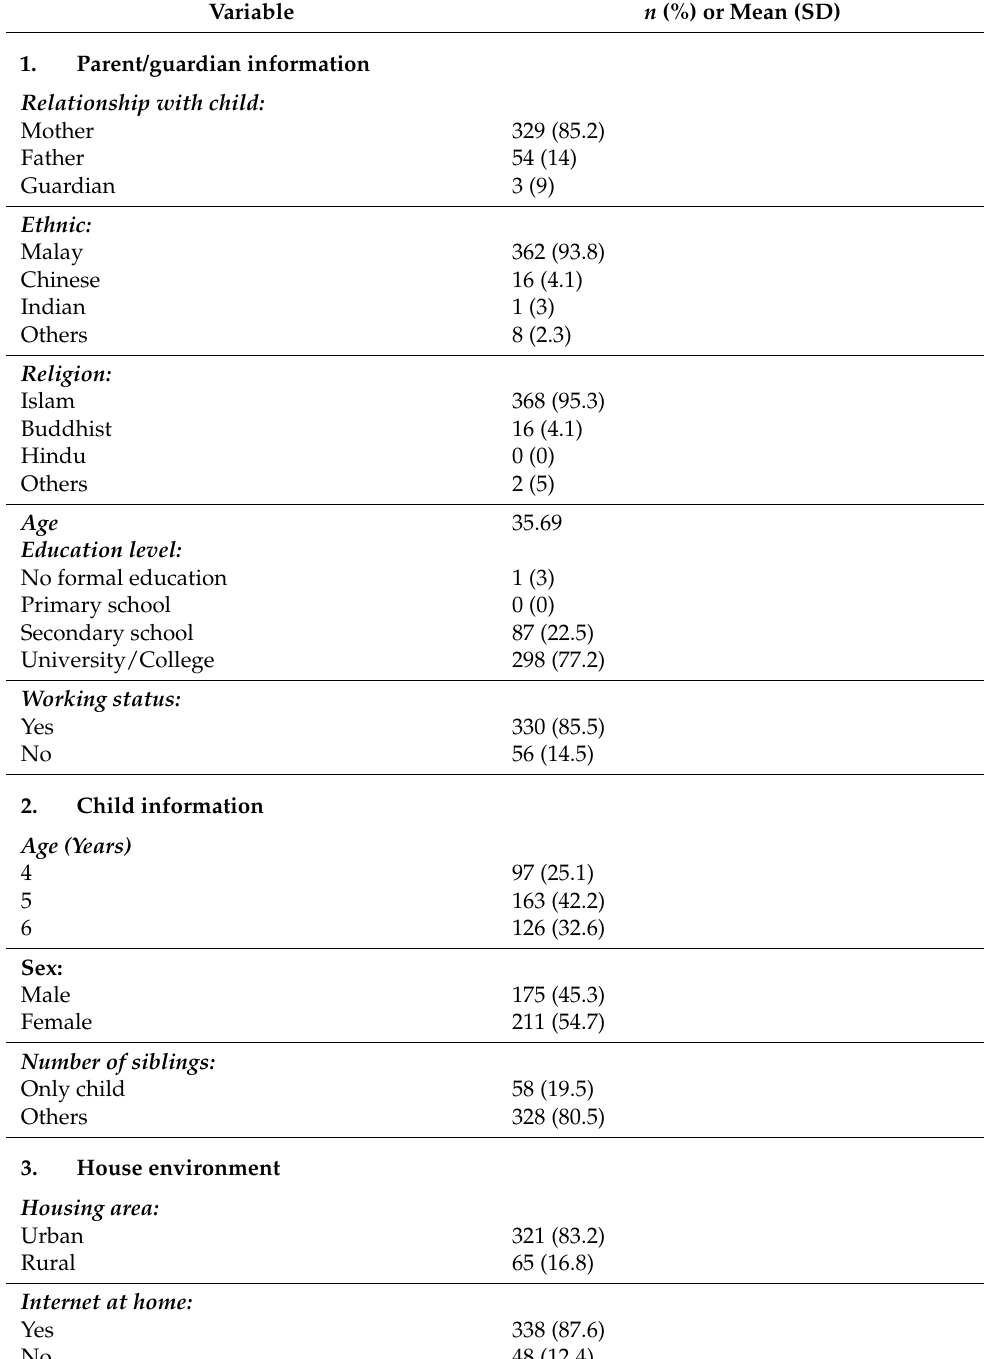
Table 1. Sociodemographic of the parent, the children involved, as well as their media viewing habits. Variable n (%) or Mean (SD)